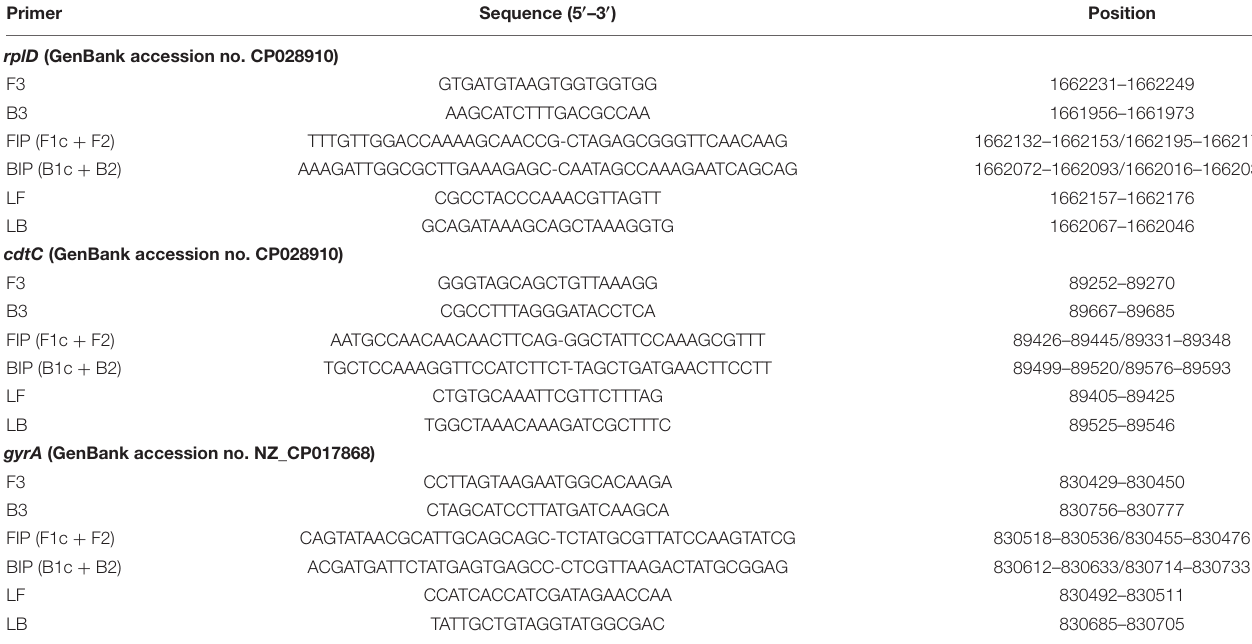
TABLE 1 | RplD -, cdtC -, and gyrA -based primer sequences used for LAMP assay establishment. Primer Sequence (5 (cid:48) –3 (cid:48) )